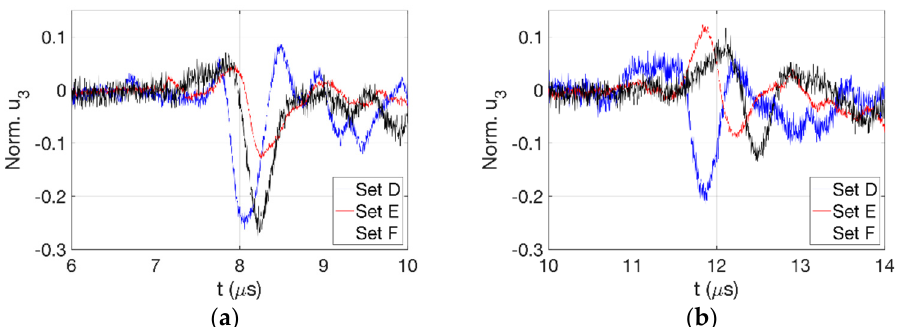
Figure 13. IN-718 process parameter sets D, E, F where processing laser speed changes. Signals received at ( a ) 23 mm, ( b ) 39 mm.